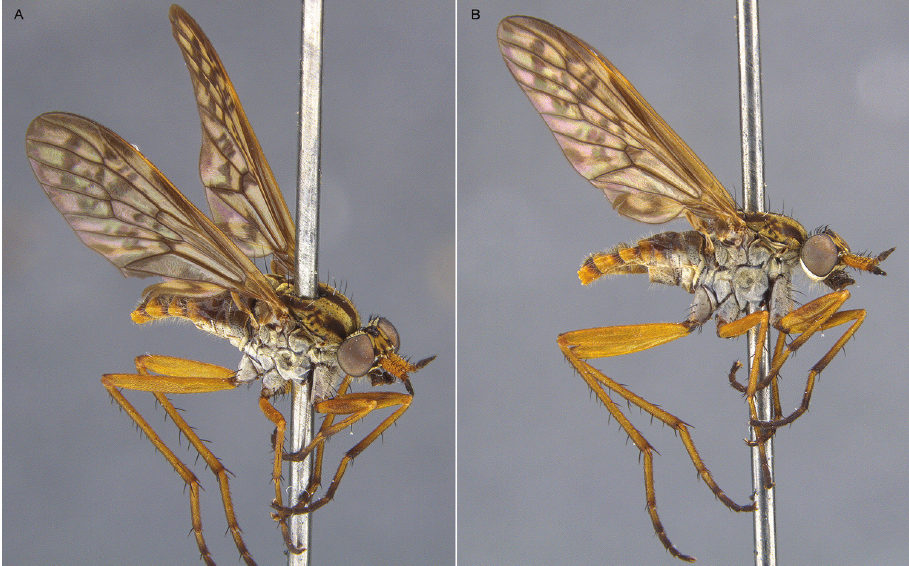
Figure 25. Zelothrix yeatesi sp. n.: A Female oblique view B same, lateral view (terminalia